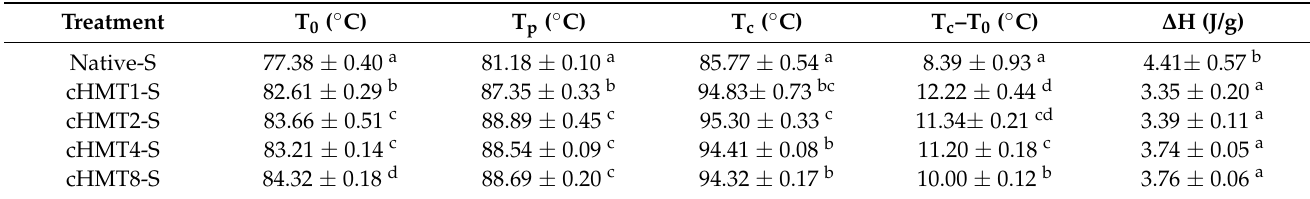
Table 2. Thermal properties of native/cHMT samples 1,2 .